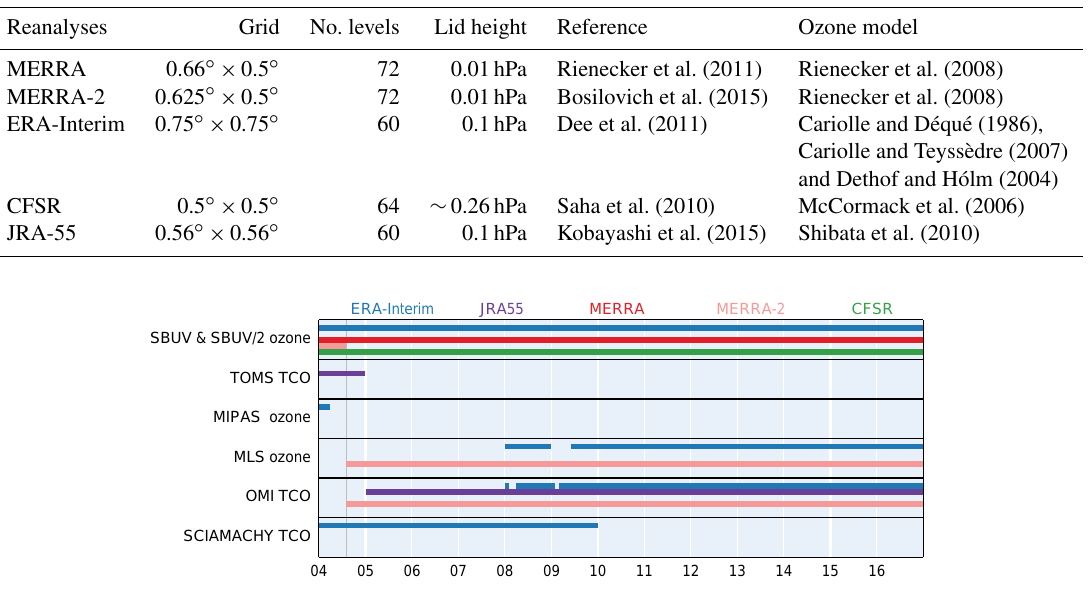
Figure 2. Timelines of ozone observations (vertical profiles and total column ozone – TCO) assimilated during the MLS/OMI period by the ERA-Interim (blue), JRA-55 (purple), MERRA (dark red), MERRA-2 (light red), and CFSR (green) reanalysis systems. Based on Fig. 9 from Fujiwara et al. (2017). Gray vertical line indicates the start of the OMI and MLS measurements. Note that JRA-55 does not assimilate OMI TCO directly; first, ozone concentrations are estimated using a chemistry transport model and then nudged to the TCO observations (Kobayashi et al., 2015; Fujiwara et al.,